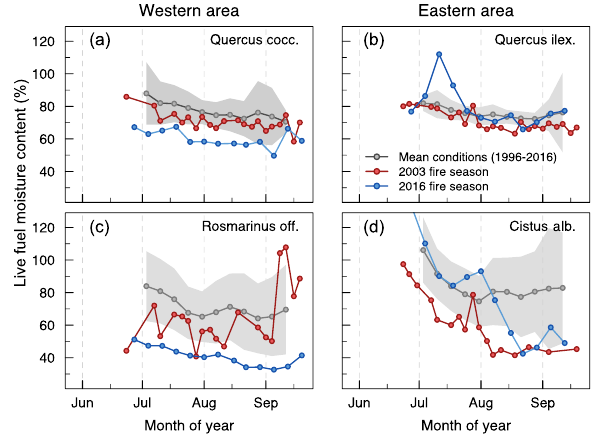
Figure 8. Seasonal dynamics of live fuel moisture content during the 2003 and 2016 fire seasons in the western and eastern areas. Mean (points) and standard deviation (shaded area) for the period from 1996 to 2016 are